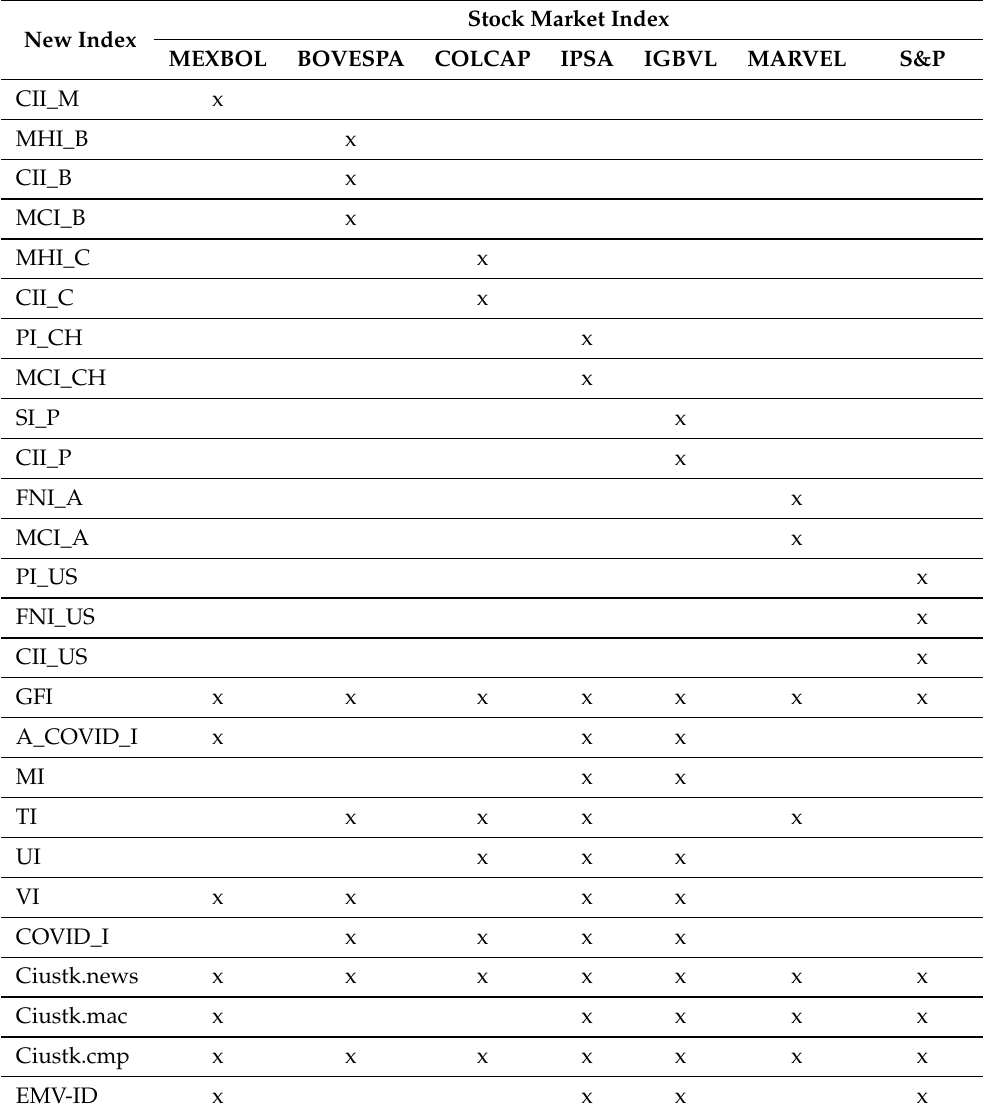
Table 3. One-way Granger-causality